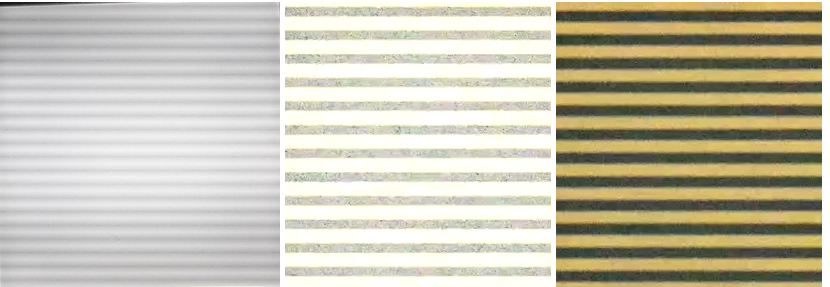
Figure 6. Rolling shutter effect: ROI of images containing an LED-based lamp switching at 1500 Hz, acquired with a rolling shutter camera at 25 fps with different frame resolution and environmental lighting